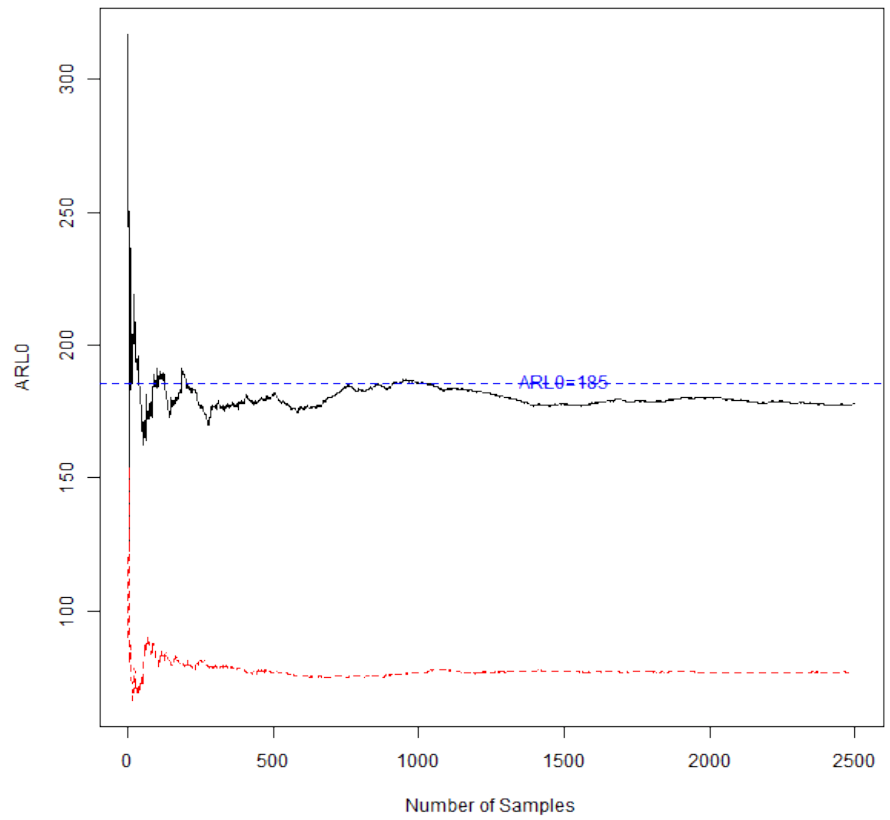
Figure 1. The simulated values of ARL 0 for the MS-MAE chart (solid line) and T 2 -MAE chart (dash